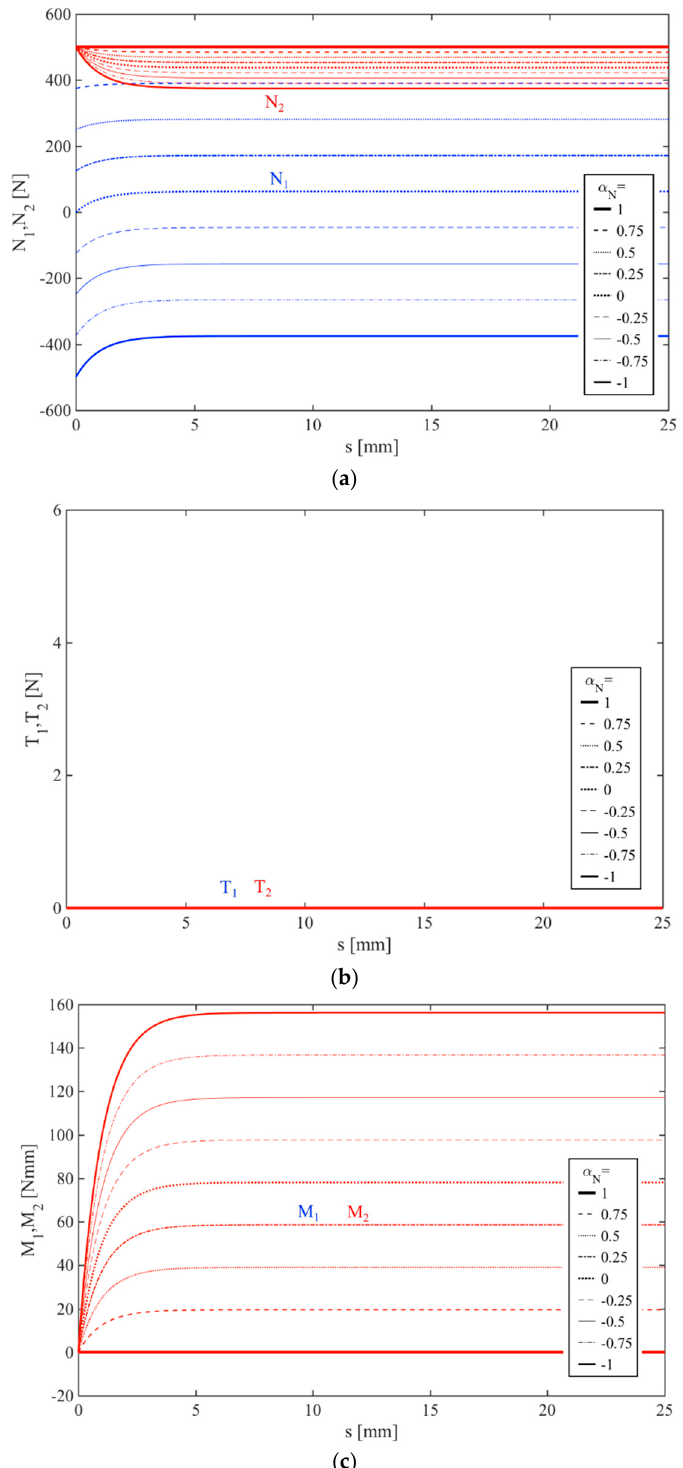
Figure 4. Effect of the axial loading on the static response of the sublaminates: ( a ) Axial force; ( b ) Shear force; ( c ) Bending moment. (Isotropic specimen).